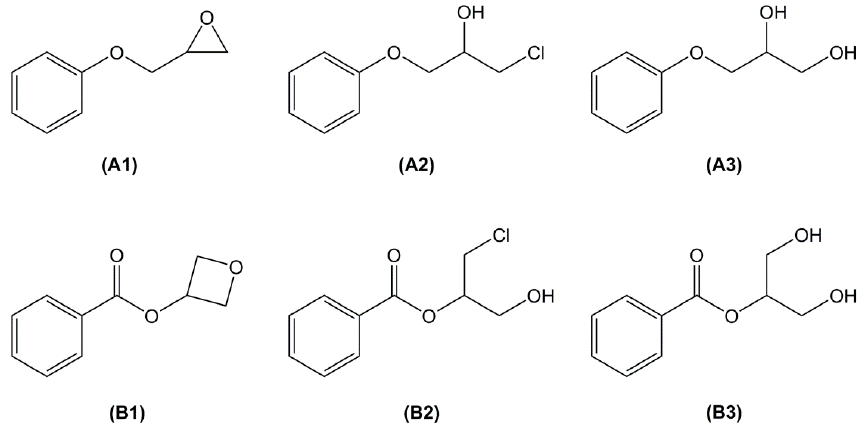
Figure 1. Common side-products of the direct glycidylation of phenol ( A1 – A3 ) and benzoic acid ( B1 – B3 ). Molecules 2017 , 22 , 149 4 of